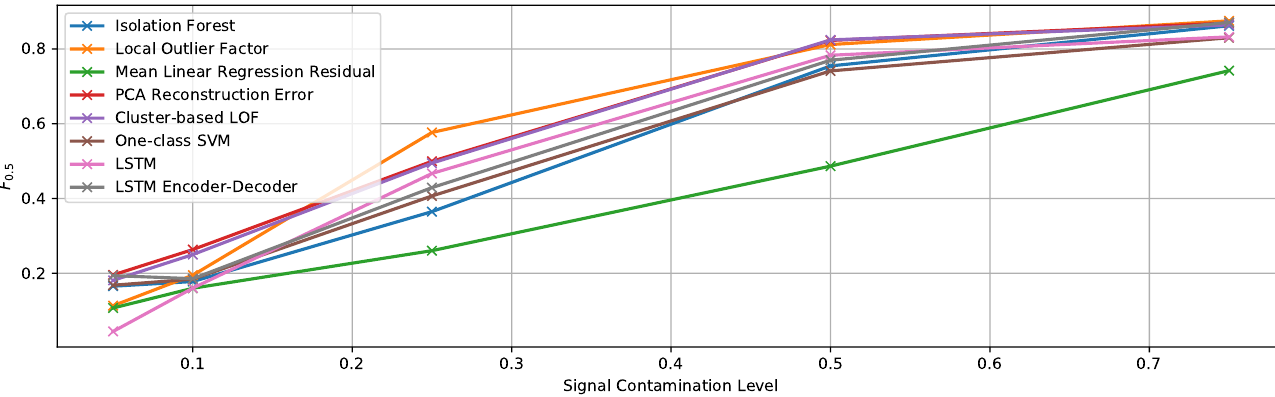
Figure 13. F 0.5 score of the multivariate detection methods using the true contamination value for experiment